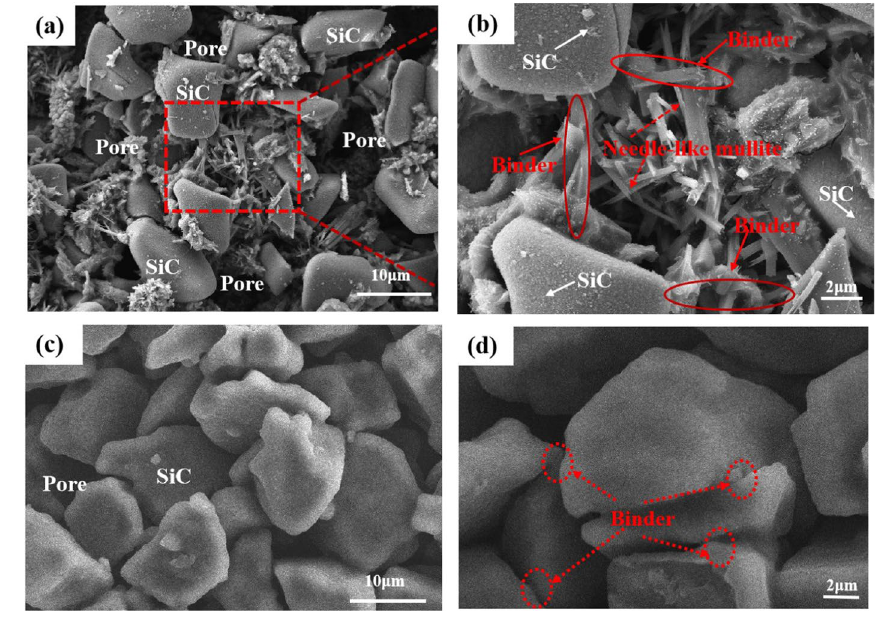
Fig. 2 SEM images of the